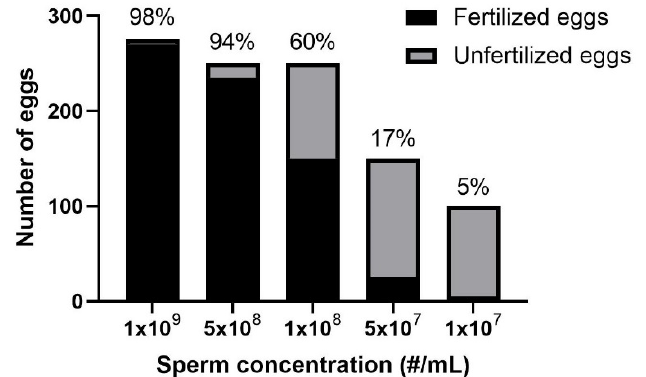
Figure 3. In vitro fertilization with frozen sperm at different concentrations. Each thawed sperm sample was exposed to a different number of eggs. In each case, the number of eggs collected was manually estimated to be a surplus of what each respective sperm sample could fertilize based on the concentration. Percentage fertilization is indicated on top of the bars.